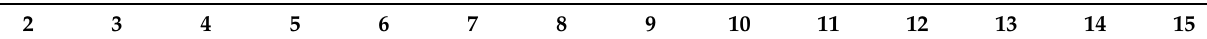
Table 4. Means, Standard Deviations, Zero-Order Pearson-Correlations, and Alphas of all Study